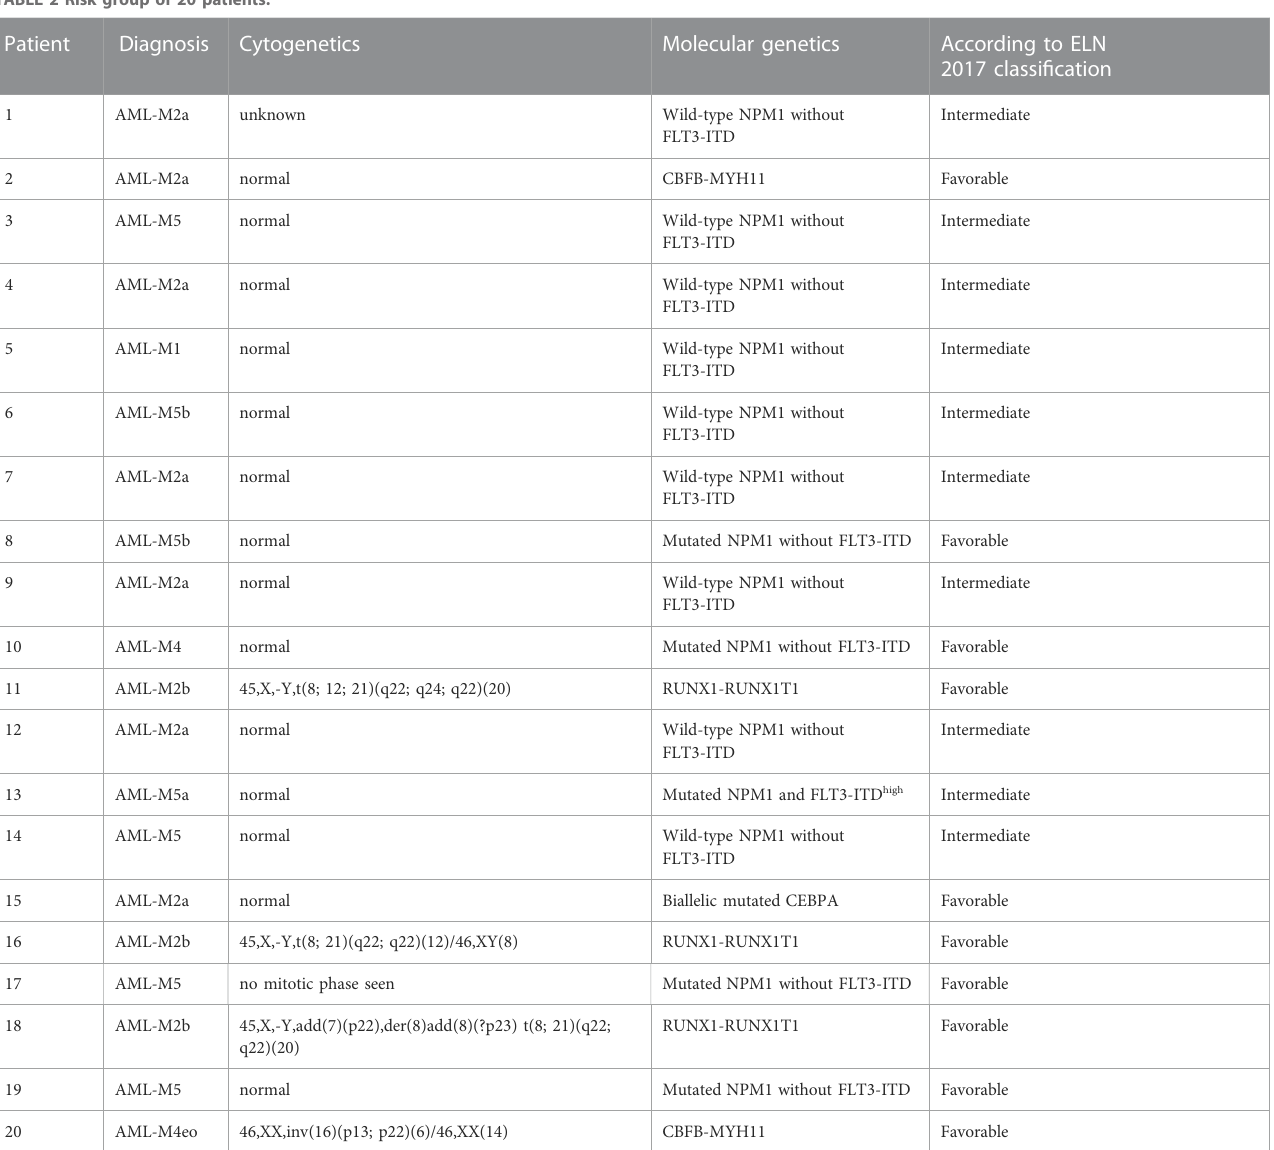
TABLE 2 Risk group of 20